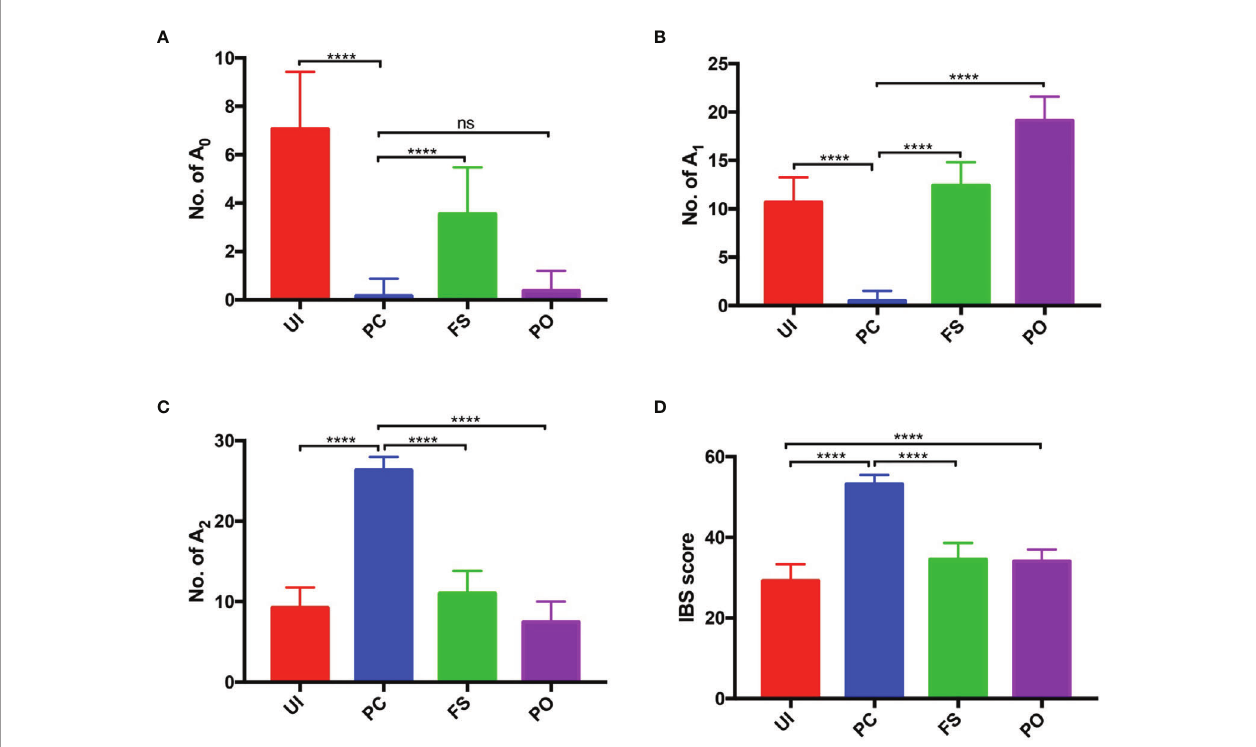
FIGURE 3 | Histogram of number of A n in PC, UI, and FS. (A) Number of the loci with 0 identical alleles (A 0 ). (B) Number of the loci with 1 identical allele (A 1 ). (C) Number of the loci with 2 identical alleles (A 2 ). (D) IBS score. PC, paired carcinoma; UI, unrelated individual; FS, full sibling; IBS, identity by state. ns, no signi fi cance; ****P <